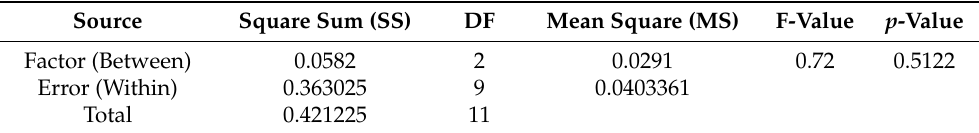
Table 11. Effect of S fiber type and temperature on f L by applying ANOVA analysis.